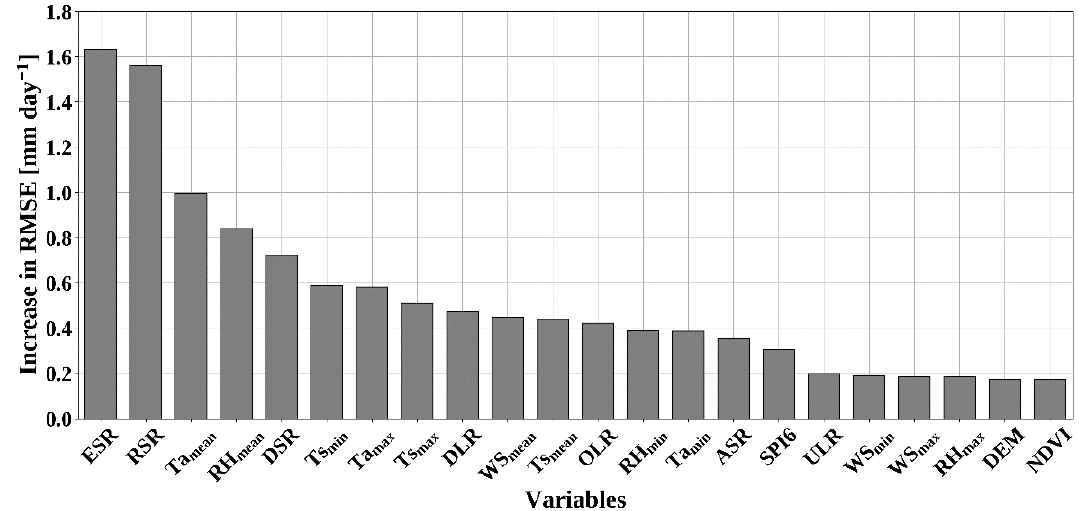
Figure 6. Mean Decrease Accuracy (MDA), expressed as the increase in RMSE, of ET derived from the ANN model.